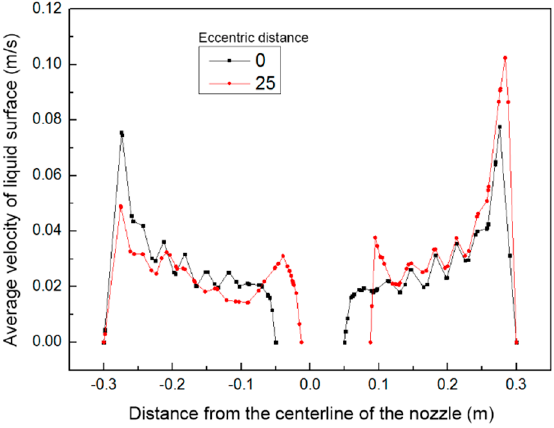
Figure 6. The e ff ect of eccentric distance on the velocity of the steel-slag Figure 6. The effect of eccentric distance on the velocity of the steel-slag interface.